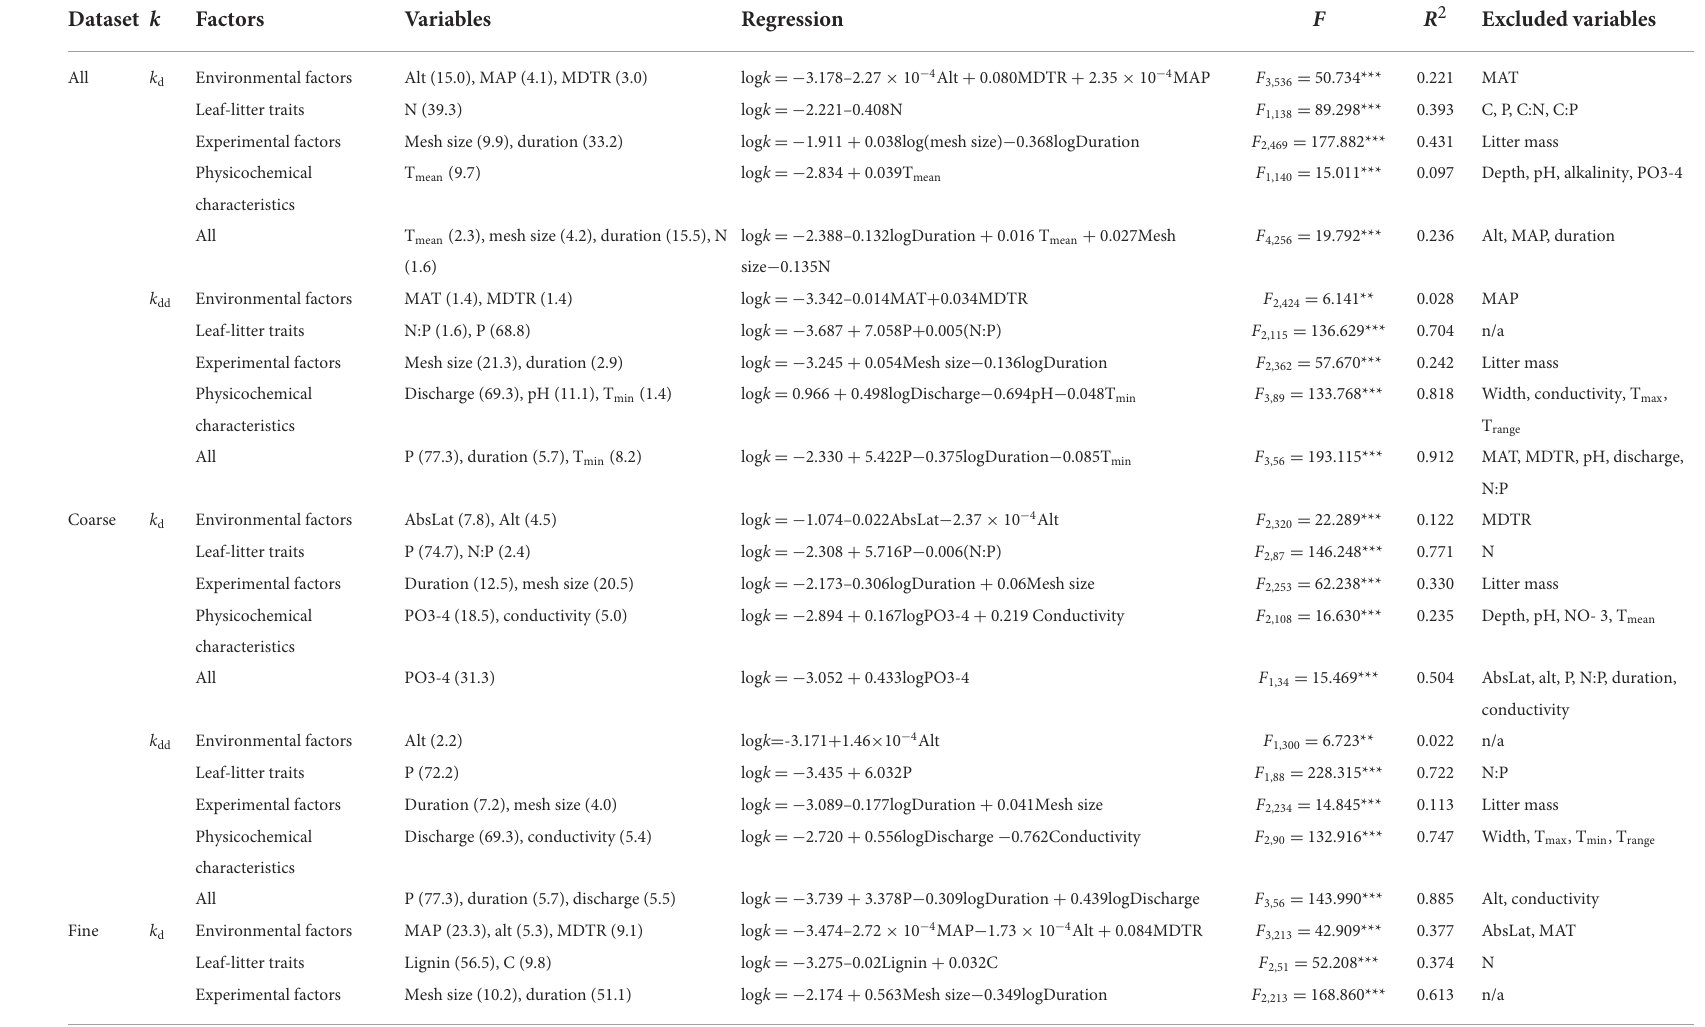
TABLE 1 Results of multiple regressions examining global-scale variations in coniferous leaf-litter breakdown rates ( k d , per day; k dd , per degree day). Dataset